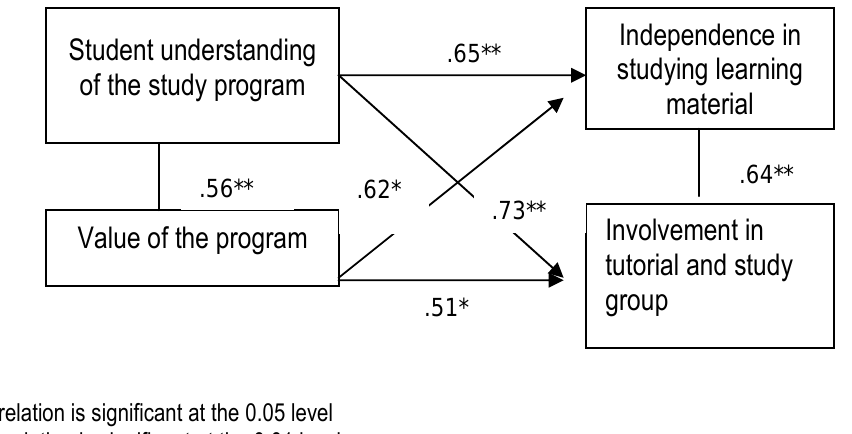
Figure 2. Correlations between